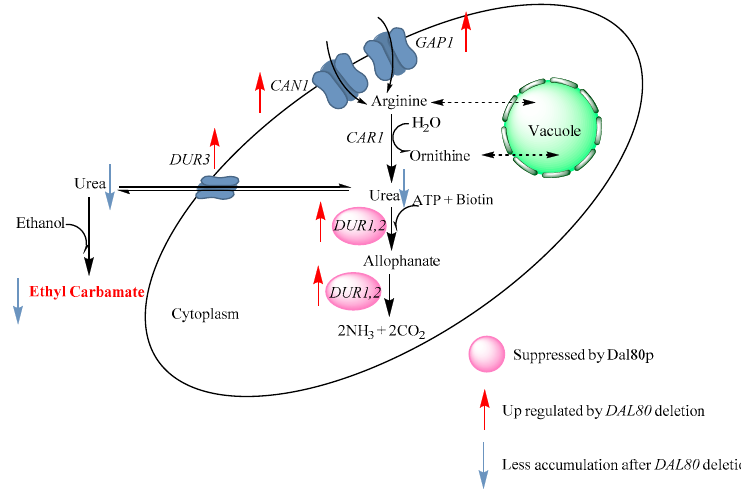
Figure 5. The proposed regulation pathway of arginine and urea metabolism by GATA factor Dal80p in S. cerevisiae.